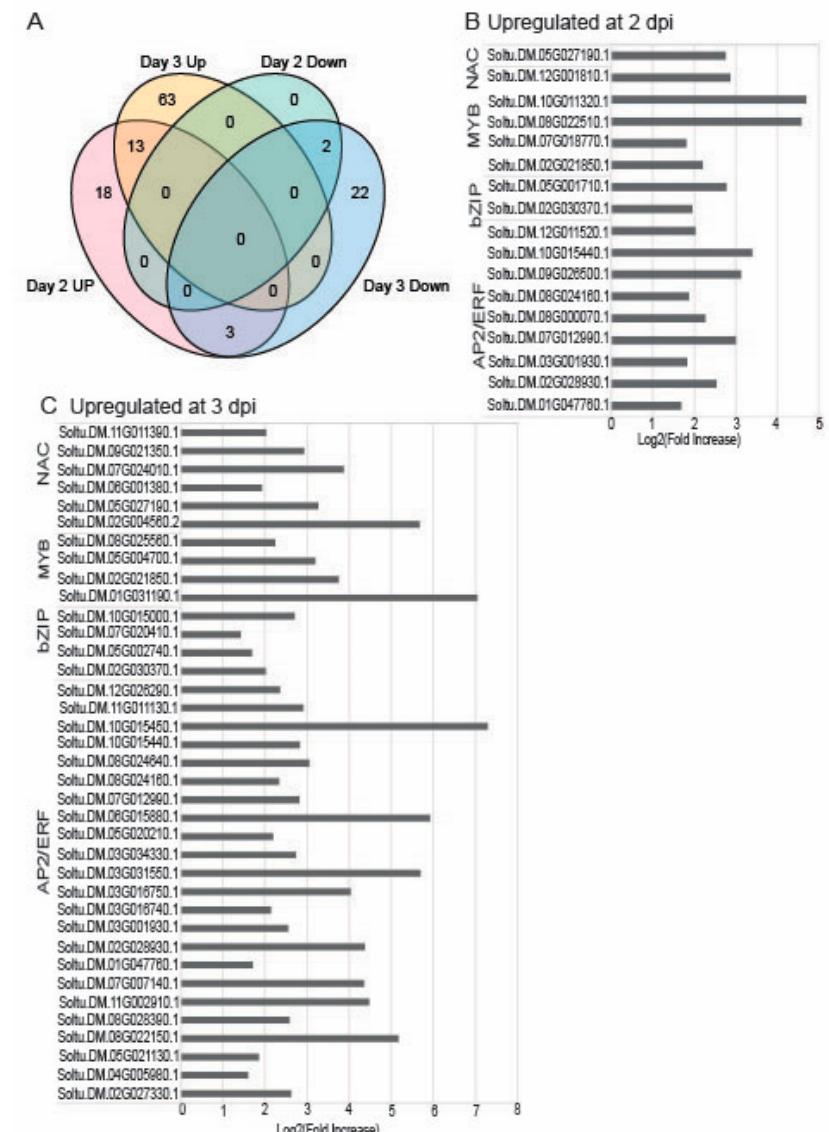
Figure 4. Differentially expressed transcription factors (TFs). ( A ) Venn diagram visualizing the overlap of differentially expressed TFs at 2 and 3 dpi. ( B , C ) Bar graphs show identifiers for genes that are upregulated at 2 and 3 dpi, respectively, with a cut-off value of >1.0. The TF families include: NAC, MYB, bZIP, and